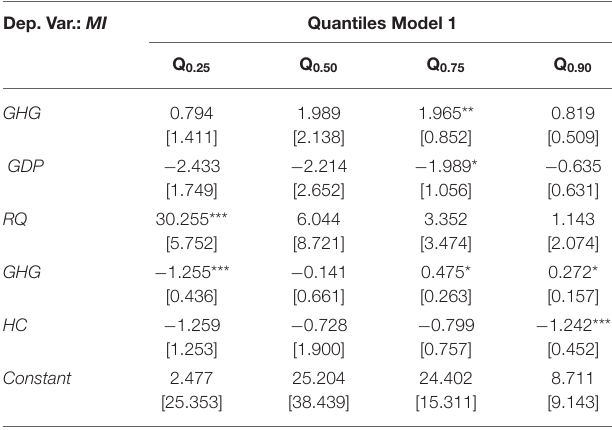
TABLE 7 | Estimates of quantile regression Model 1.